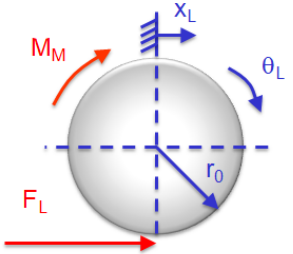
Figure 9. Simplified model of the left wheel.